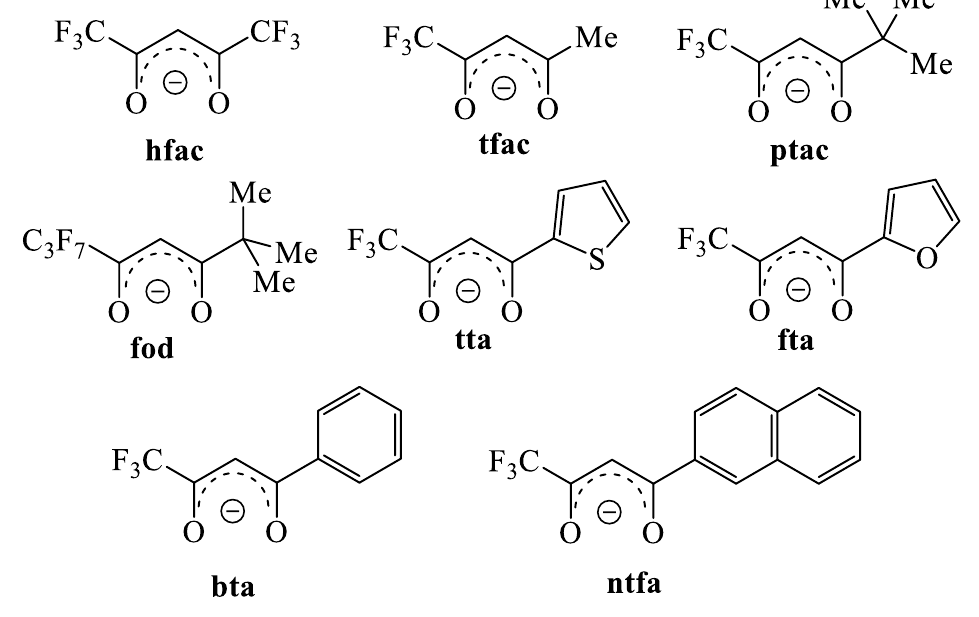
Figure 1. Structures of fluorinated β -diketonate ligands.